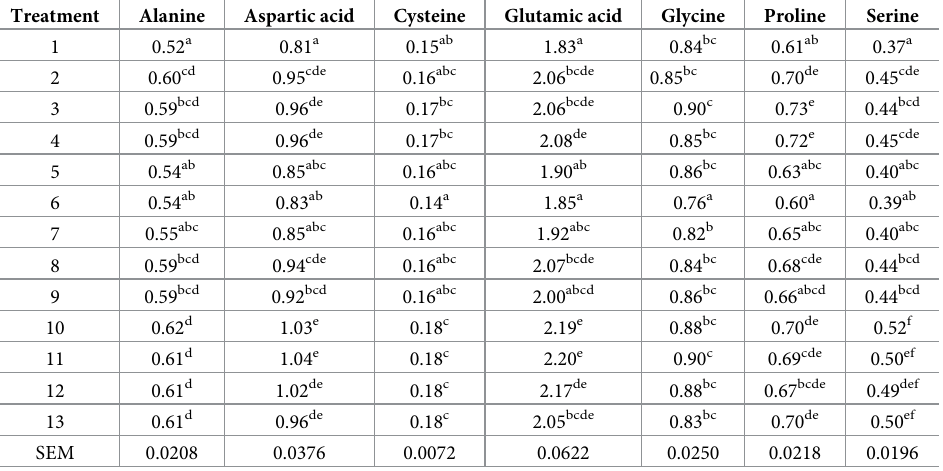
Table 17. Effects of dietary treatments on apparent disappearance rates (g/bird/day) of non-essential amino acids at 28 days post-hatch.